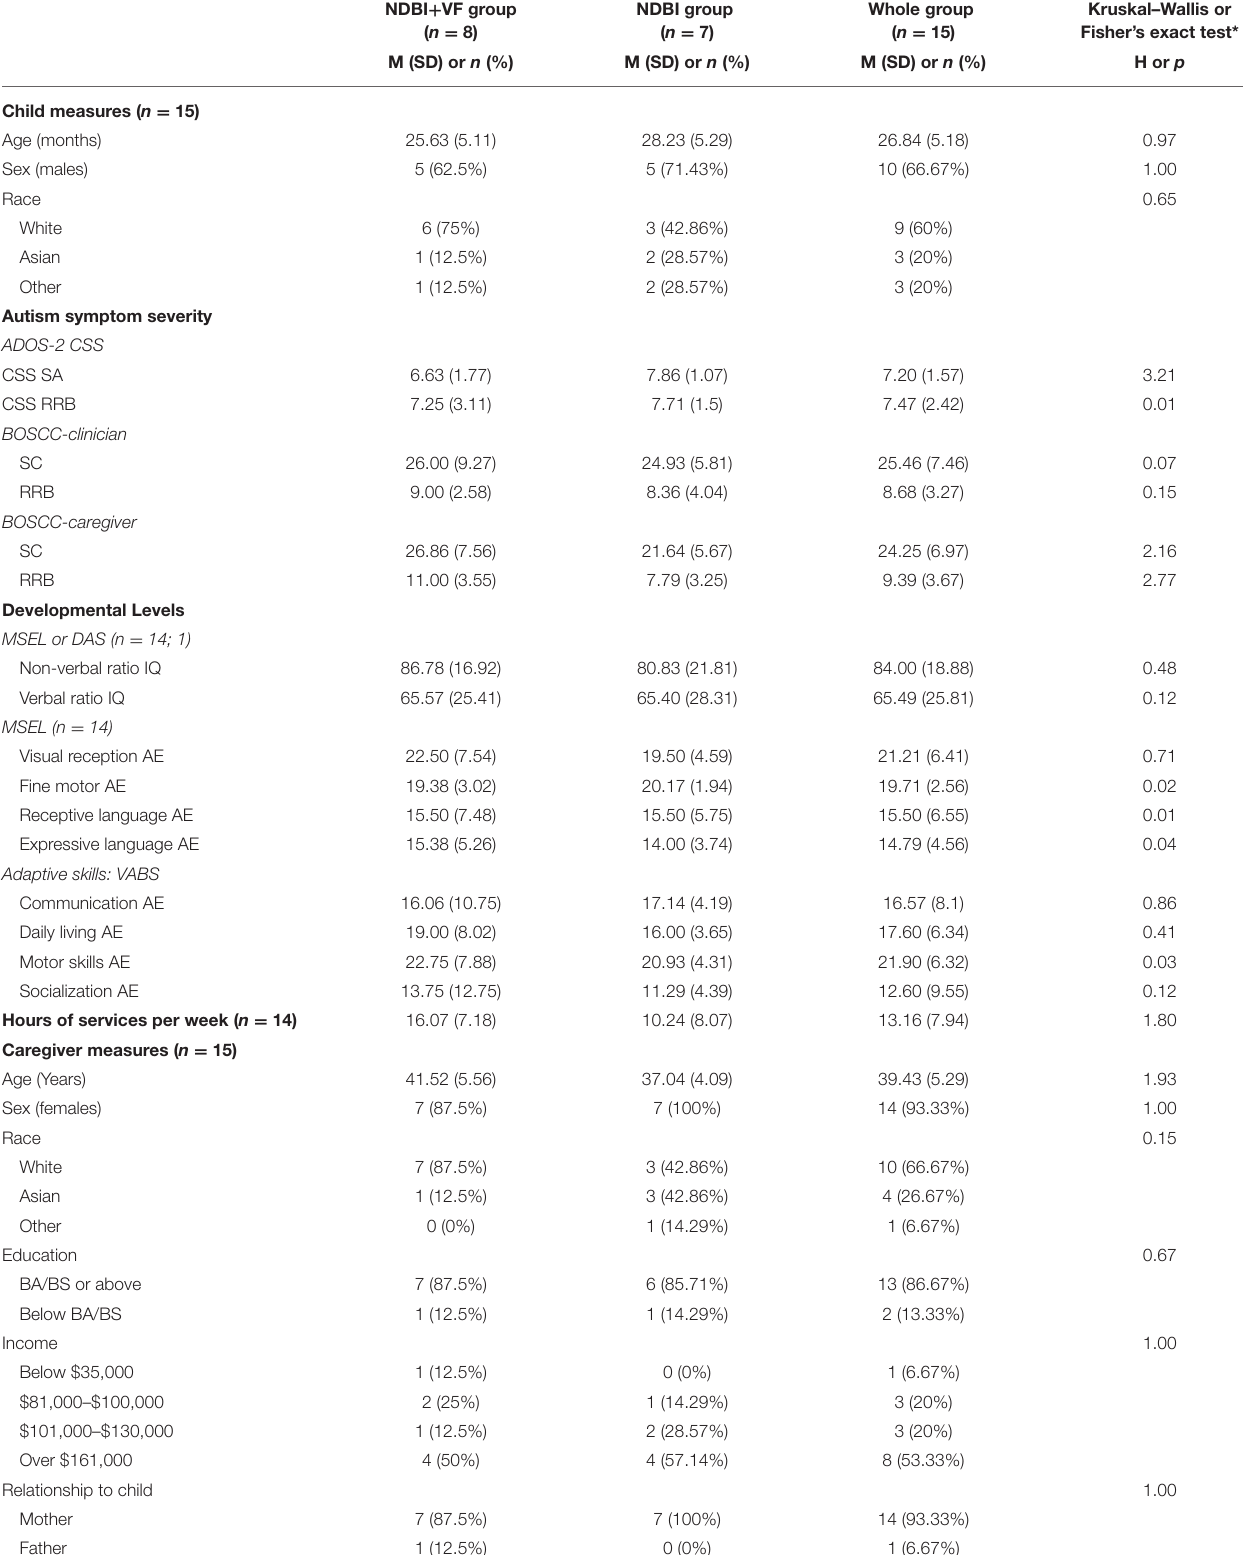
TABLE 1 | Baseline demographics and tests of group differences (Kruskal–Wallis or Fisher’s exact